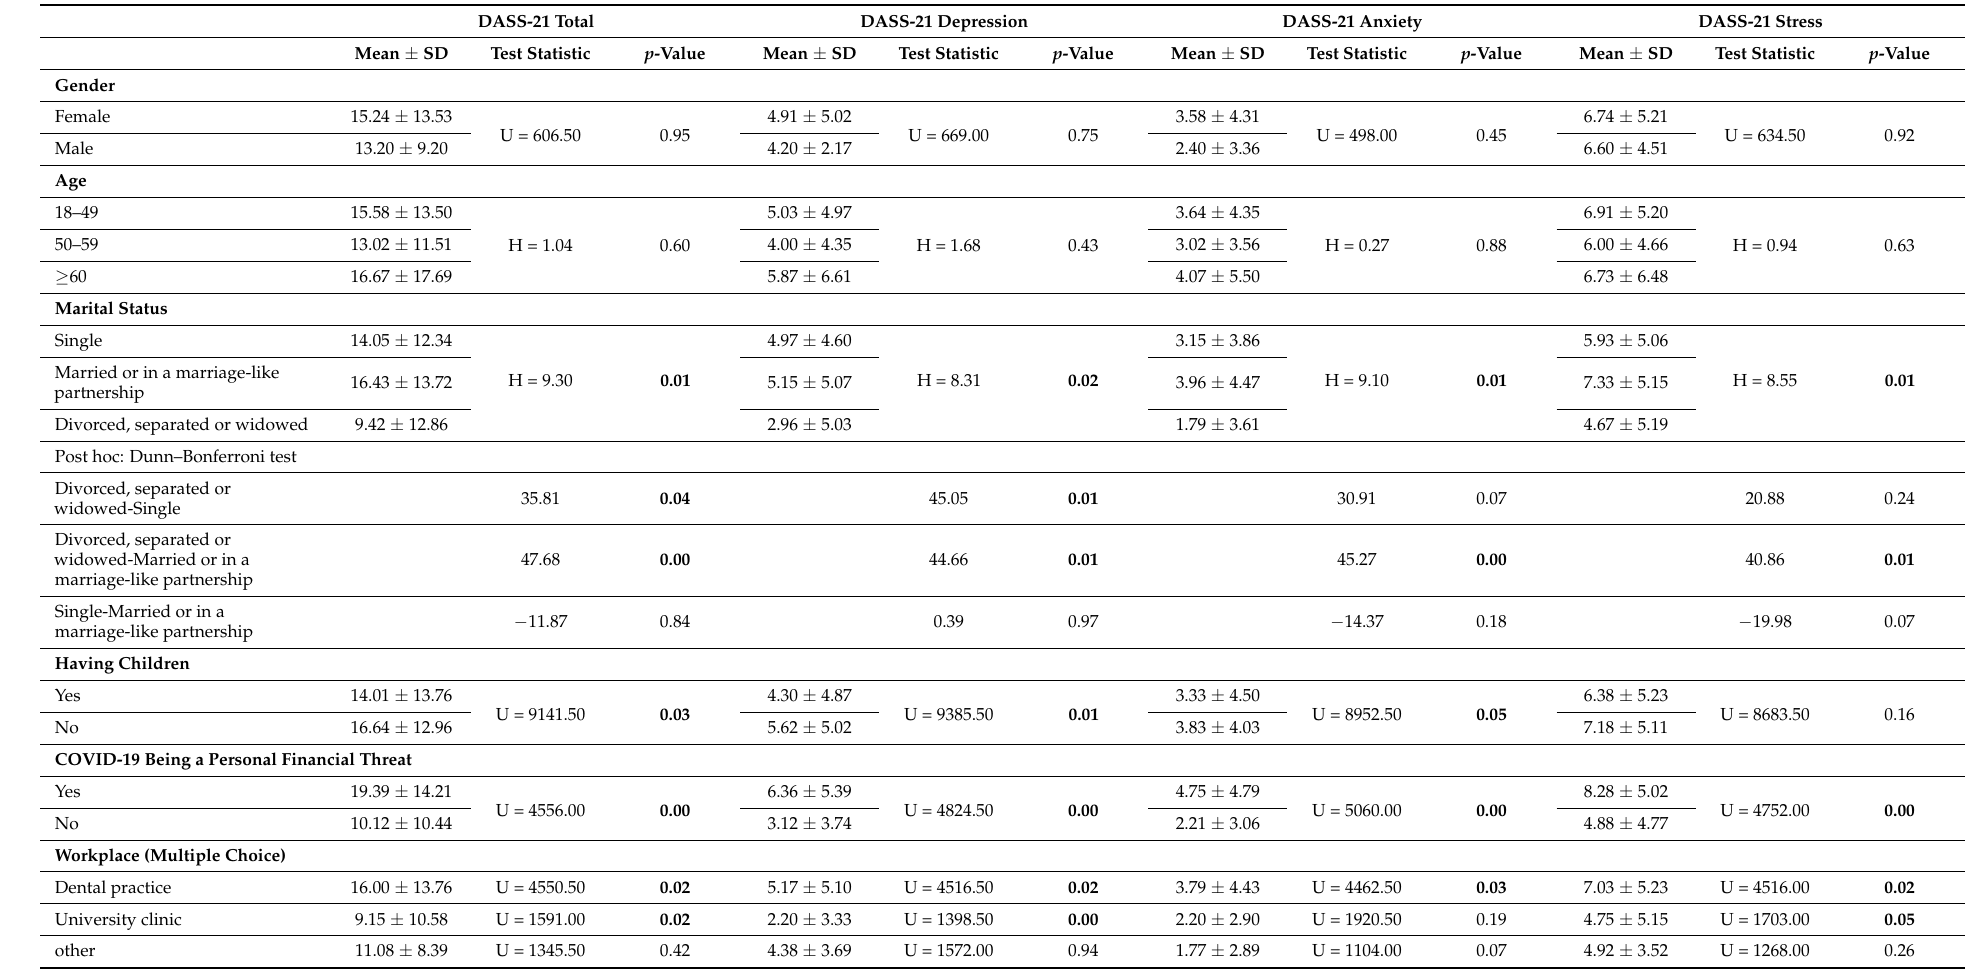
Table 4. Differences in DASS-21 total and subscale scores based on individuals’